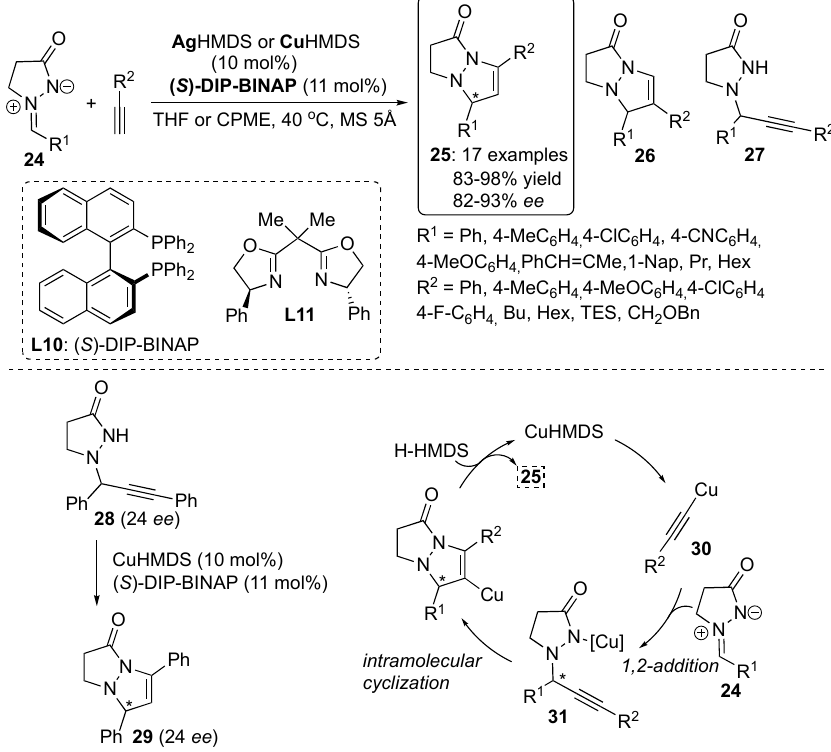
Scheme 10. Regioselective formation of 5,7-disubstituted bicyclic pyrazoline derivatives. Tetrahydrofuran = THF, CPME = cyclopentyl methyl ether, MS = molecular sieves, TES = triethylsilyl, DIP-BINAP = 2,2 ′ -bis(3,5-diisopropylphenylphosphino)-1,1 ′ -binaphthalene.3. Synthesis of pyrazolidines 2,2 (cid:48) -bis(3,5-diisopropylphenylphosphino)-1,1 (cid:48)